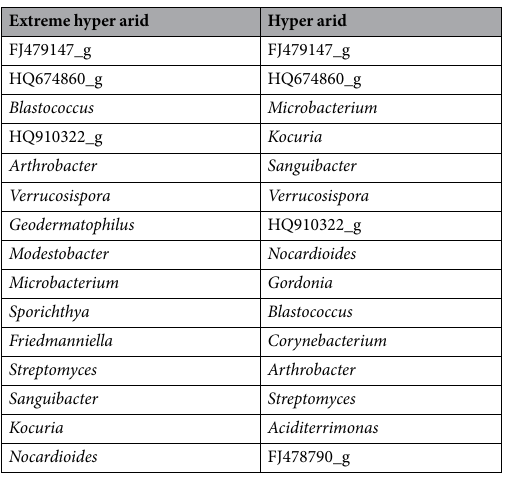
Table 2. Most abundant genera of the extreme hyper-arid and hyper-arid core microbiomes. The order of genera indicates their comparative dominance within each microbiome.